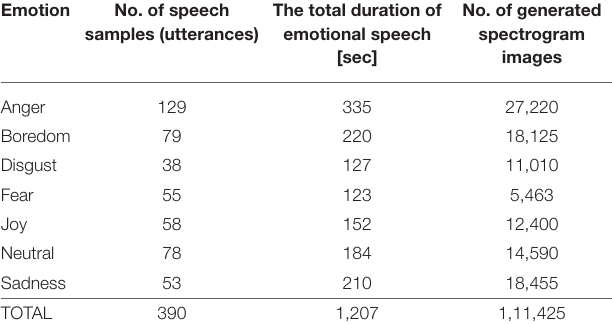
TABLE 2 | Speech data characteristics—the number of utterances, total duration, and the number of spectrogram images generated for each emotion of the EMO-DB